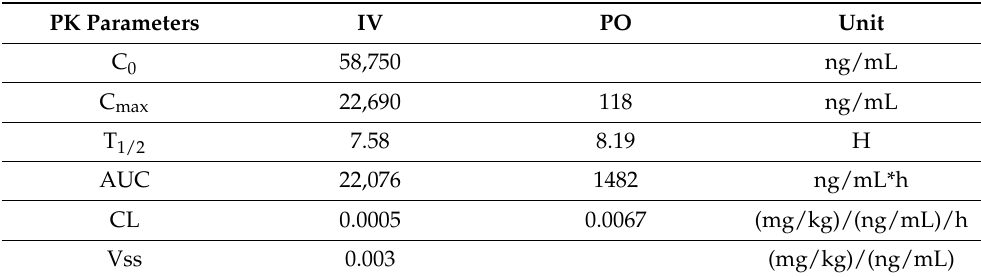
Table 1. Summary of pharmacokinetics parameters following a single IV bolus or PO administration of NBD-14189 in Rats.